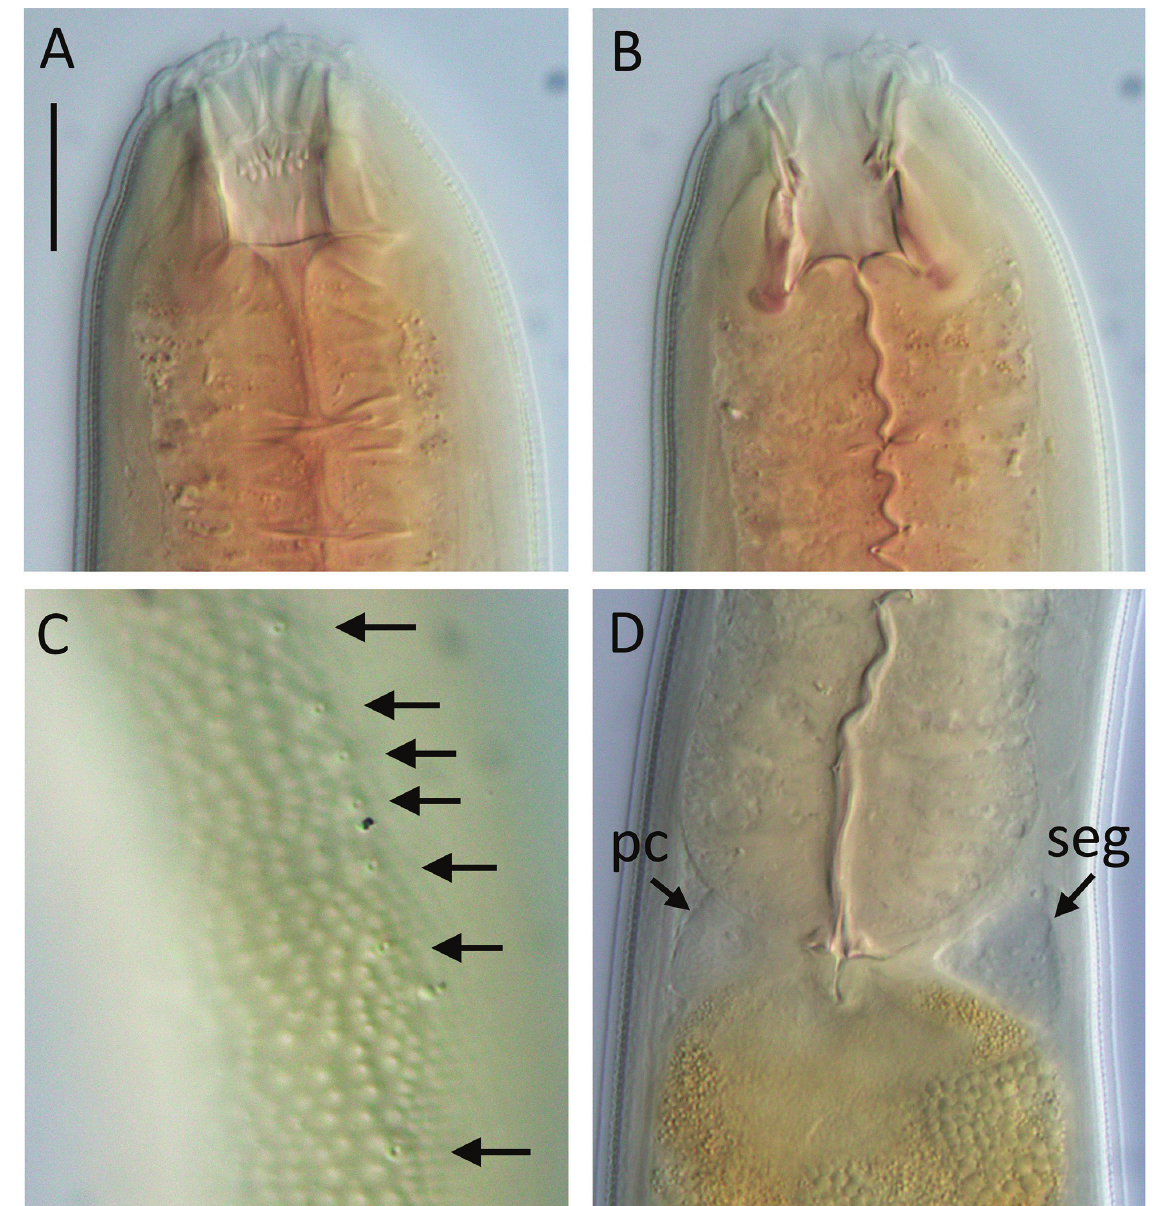
Fig. 6. Halichoanolaimus ossilagulus sp. nov. Light micrographs. A , B . Cephalic region of paratype ♀ (NIWA 139247), showing structure of buccal cavity. C . Cloacal region of holotype ♂ (NIWA 139246), showing cuticle ornamentation and pore complexes (arrows). D . Junction of pharynx and intestine of paratype ♀ showing position of secretory-excretory gland (seg) and pseudoceolomocyte (pc). Scale bar: A–B = 15 µm; C = 11 µm; D = 17